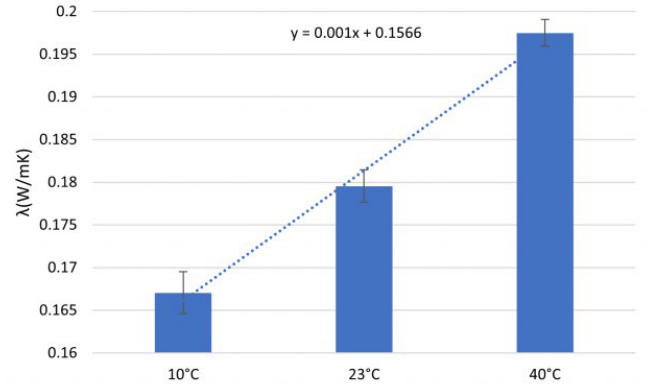
Figure 6. Cob samples’ thermal conductivity at different temperatures.